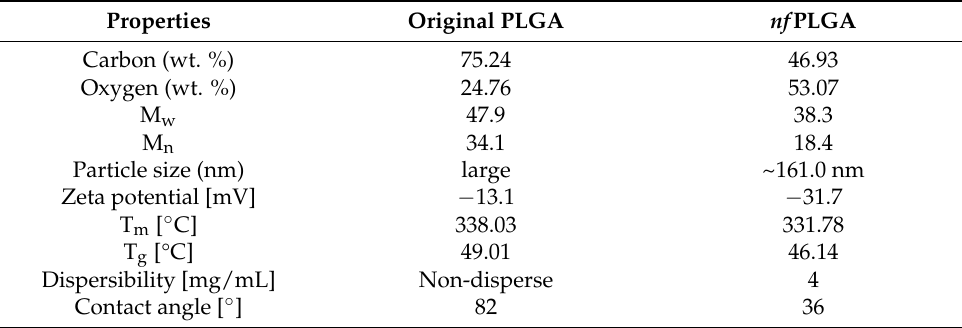
Figure 1. Photograph of ( a ) pure PLGA and ( b ) nf PLGA dispersion in water. Table 1. Physical properties of PLGA and nf PLGA